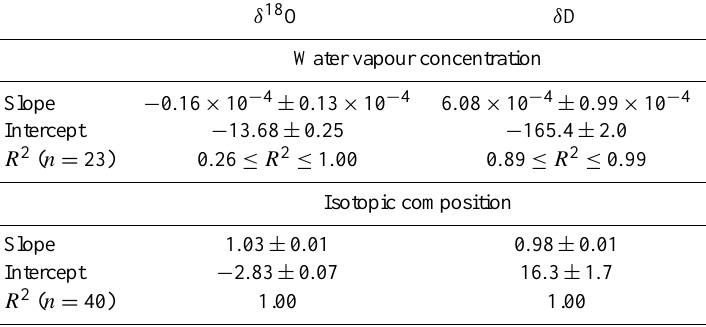
Table 2. Evaluation of the stability of the calibrations in water vapour concentration and isotopic composition, with mean slope and mean intercept ± 1 standard deviation obtained for δ 18 O and δ D with n calibrations performed from 20 July to 24 August 2011.